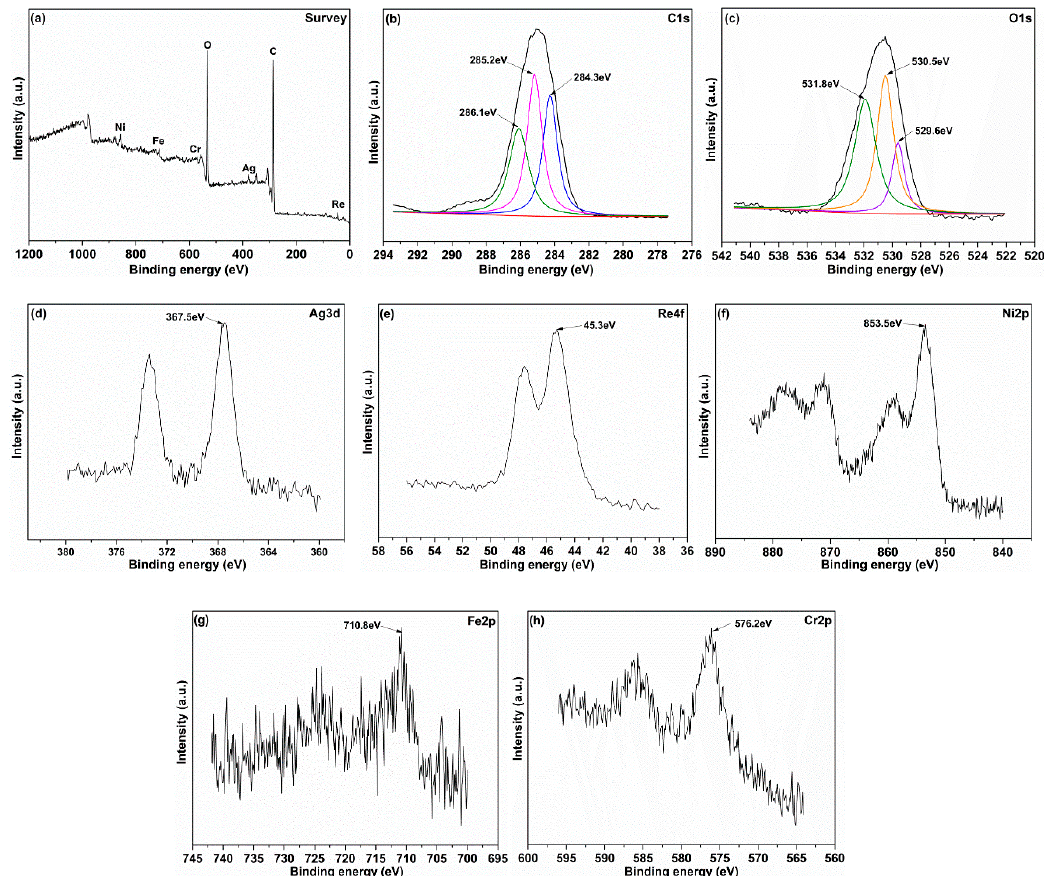
Figure 10. The mean width values of worn tracks lubricated by different lubricants at various temperatures.